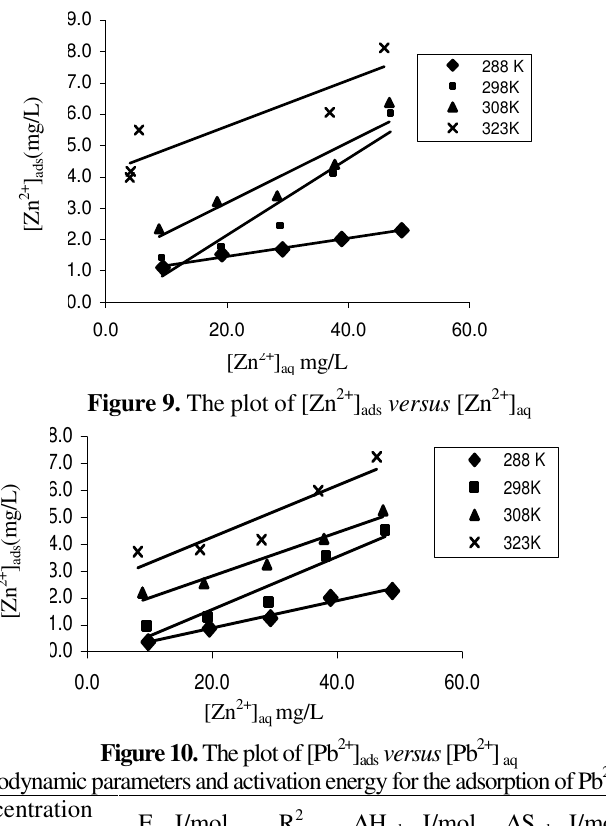
versus [Pb 2+ ] ads aq